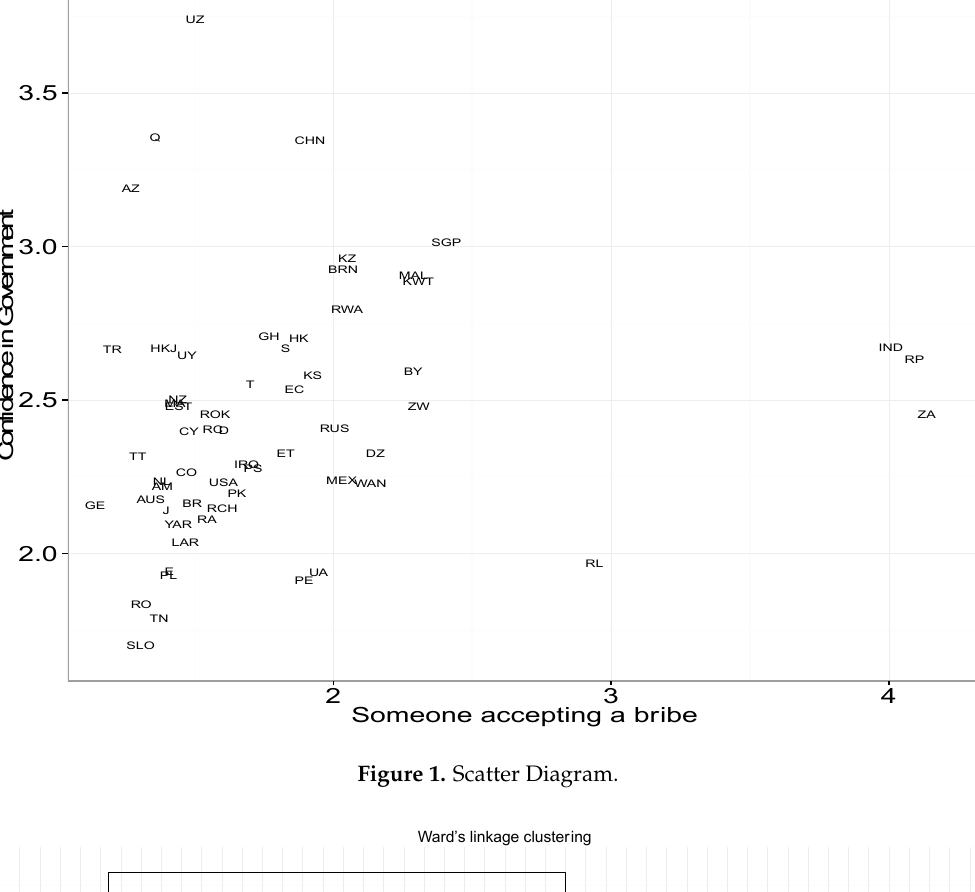
Figure 3. Number of clusters chosen by 26 criteria. After the visual segmentation of the countries we determined the centers of each cluster: Brazil (Cluster 1) and Rwanda (Cluster 2). As a result, the objects fall within the cluster, the distance to the center of which is minimal. Thus we obtain two groups of the countries according to the level of bribery acceptability and the level of confidence in government (see in Figures 4 and 5).